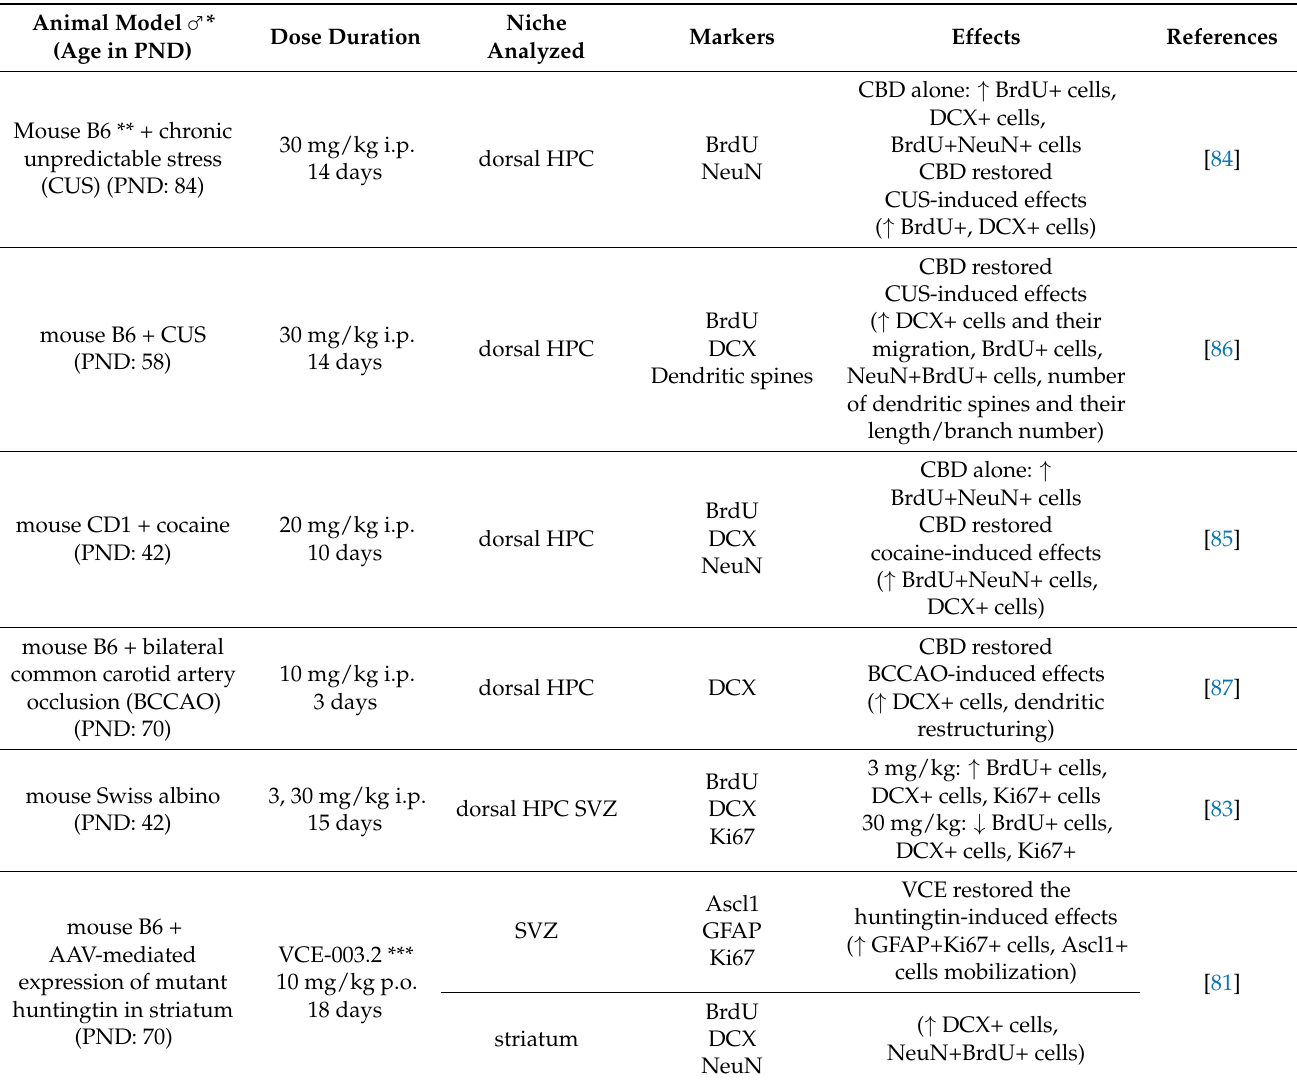
Table 3. CBD effects on